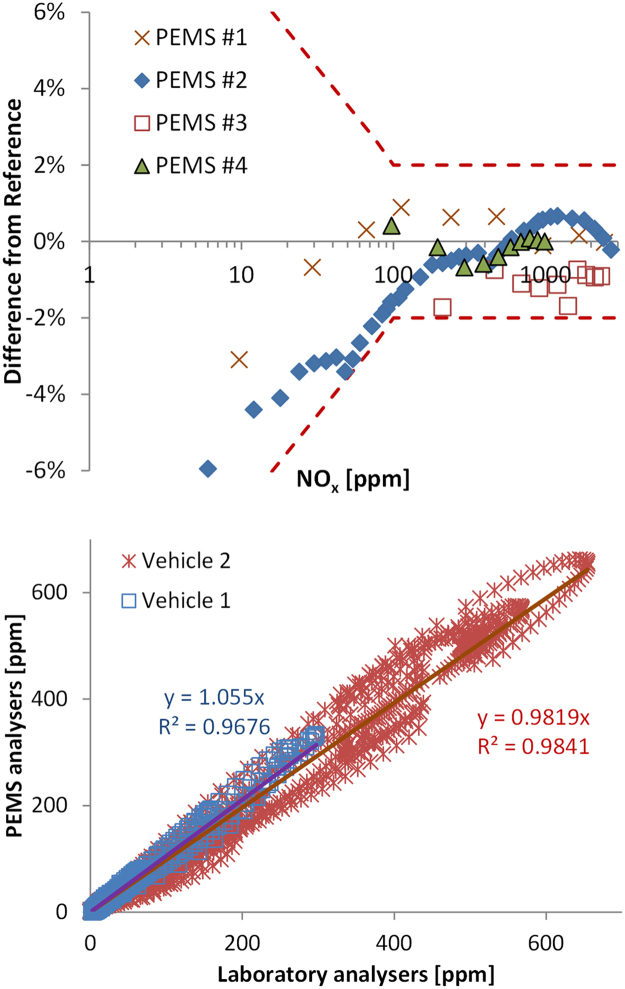
Upper panel: Examples of calibration data of NO analysers from 4 different PEMS manufacturers at different concentration levels. NO2 analysers are typically calibrated at lower range (< 1000 ppm). Lower panel: Correlation of second by second data of PEMS and laboratory grade analysers for two vehicles (NOx emissions of vehicle 1: 10 mg/km, vehicle 2:200 mg/km).